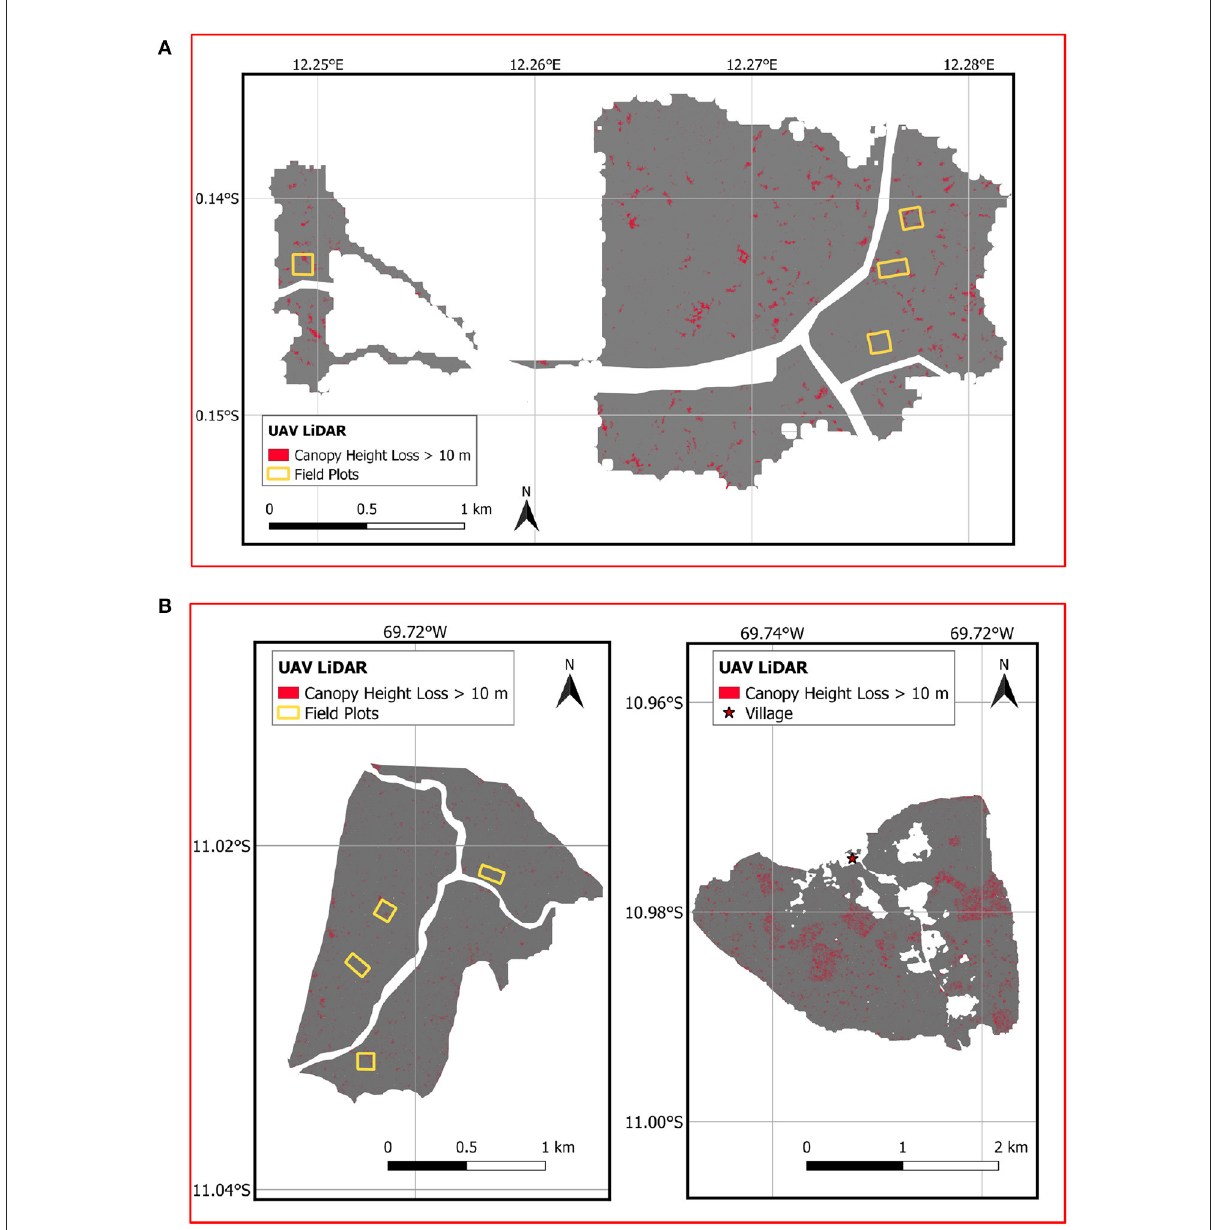
FIGURE2 Canopy height change from UAV LiDAR measurements (gray image) showing losses in forest canopy height of more than 10 m (red). (A) Canopy height loss in Gabon from January 2020 to January 2021 indicating patches of disturbance in the study plots and in the surrounding concession; (B) Canopy height loss in Peru from May 2019 to September 2021, showing fine-scale losses in the area of the study plots (left panel) and more intensive, consistent patterns of forest to agriculture conversion in proximity of the village (right panel).